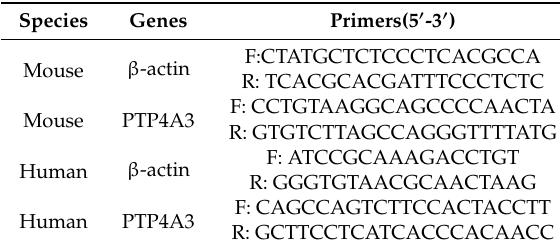
Table 1. Primers used in the